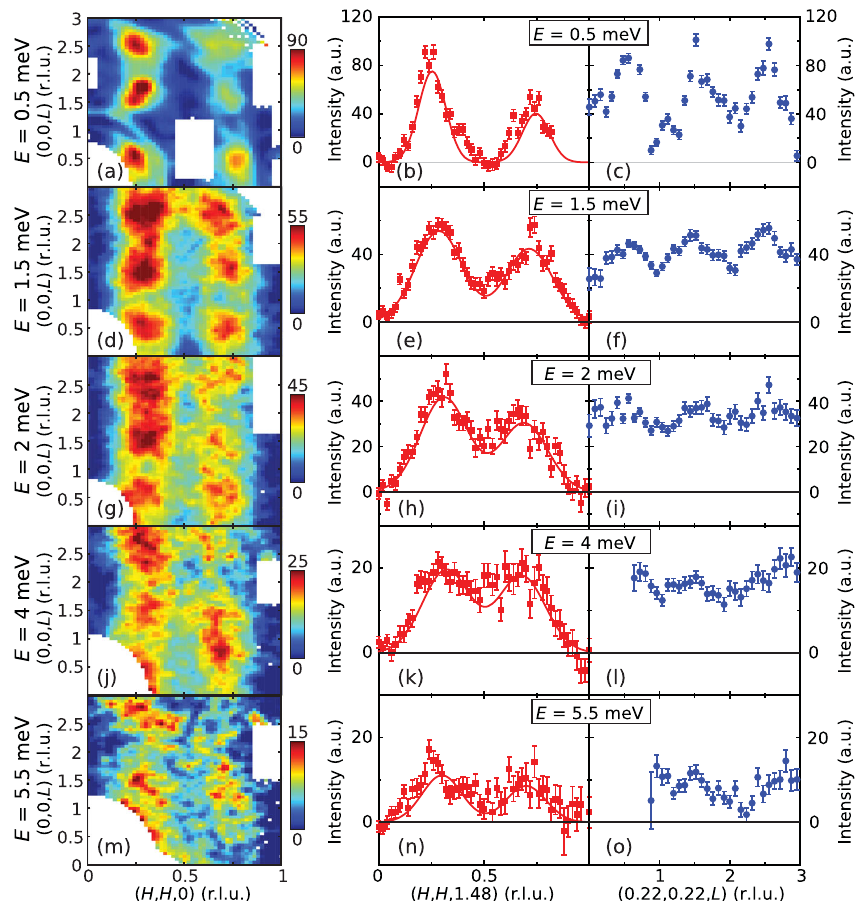
Fig. 2 Wave vector dependence of spin excitations in CeCu 2 Si 2 as a function of energy. Constant-energy maps of the [ H , H , L ] plane for different energies are shown in the left panels, corresponding cuts along the [H, H, 1.48] direction obtained by binning data with 1.38 < L < 1.58 are shown in the middle panels, and corresponding cuts along the [0.22, 0.22, L ] direction obtained by binning data with (0.17, 0.17) < ( H , H ) < (0.27, 0.27) are shown in the right panels. Data in this fi gure were measured using E f = 5 meV. All vertical error bars represent statistical errors of 1